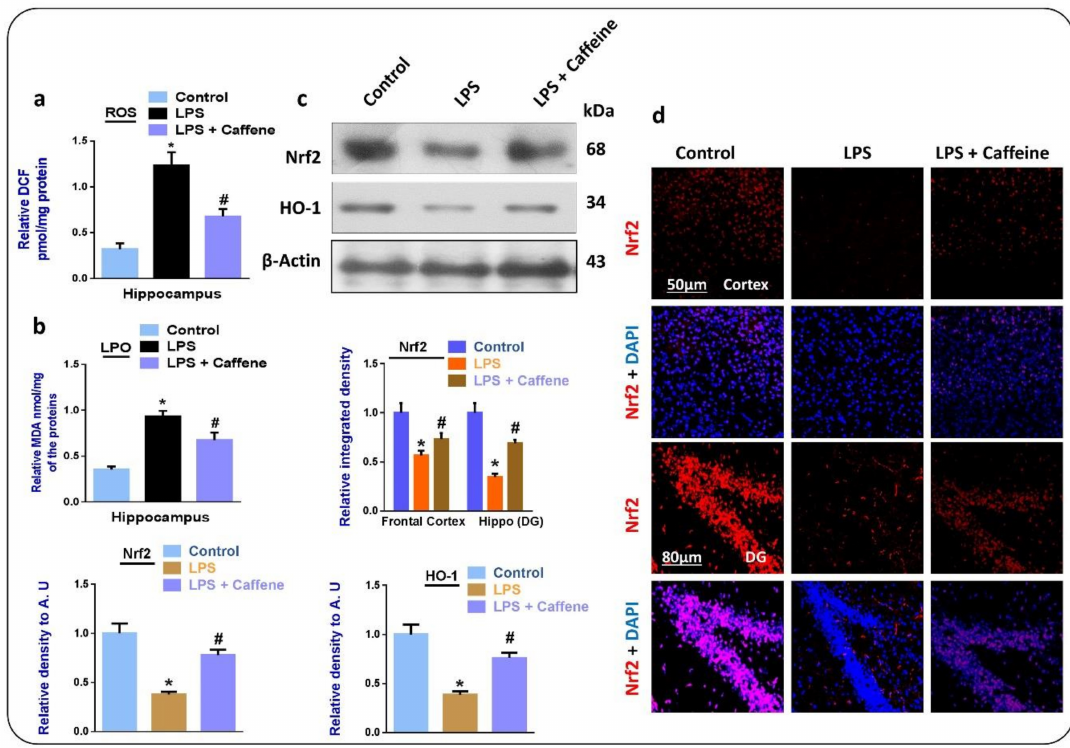
Figure 1. Ca ff eine inhibits lipopolysaccharide (LPS)-induced oxidative stress in mouse brain: ( a , b ) Results of reactive oxygen species (ROS) and lipid peroxidation (LPO) assays, respectively; ( c ) Western blot results of nuclear factor erythroid 2-related factor 2 (Nrf2) and hemeoxygenase 1 (HO-1), in the mouse brain; ( d ) confocal microscopic images of Nrf2 in the experimental groups, magnification 30 × , scale bar 50 µ m; * significantly di ff erent from the vehicle-treated control group, #, significantly di ff erent from the LPS-treated mouse group ( n = 10 mice per group; number of experiments = 3; statistical analysis used was one-way ANOVA with Tukey’s posthoc test for comparisons among the di ff erent groups). Significance: * p < 0.05; # p < 0.05. DAPI: 4 (cid:48) , 6-diamidino-2-phenylindole. DG: Dentate